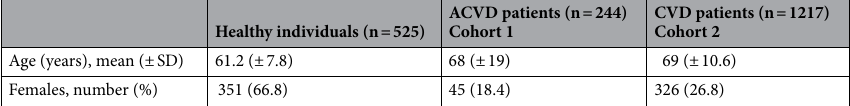
ACVD patients (n = 244) Cohort 1